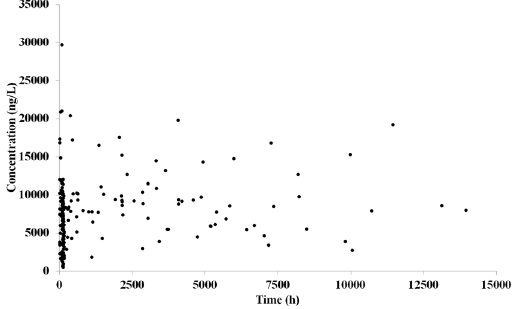
Figure 2. Scatter plot of drug concentration versus time. Each dot represents a data